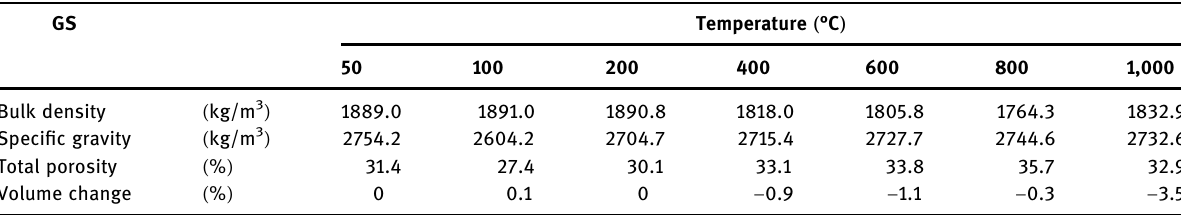
Table 5: Basic physical characteristic of composite with silica sand ( GS )